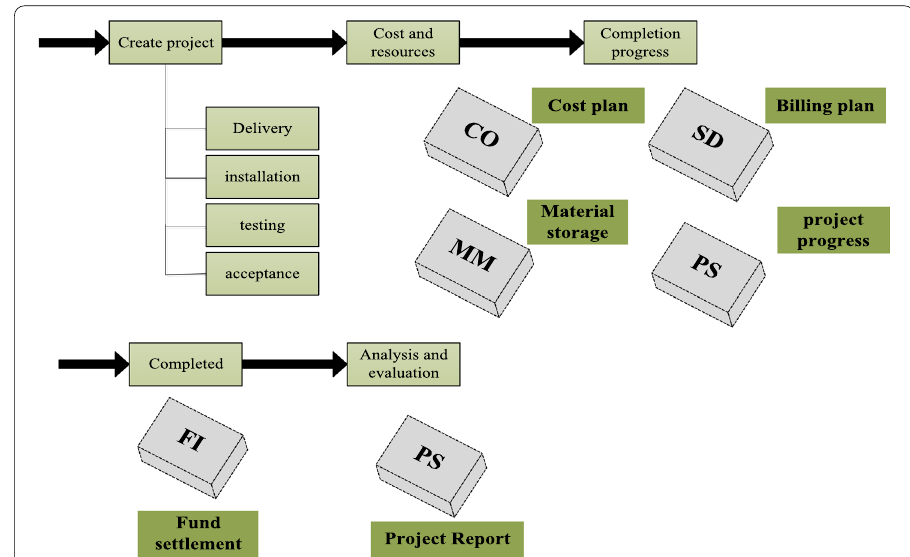
Fig. 6 Project process diagram